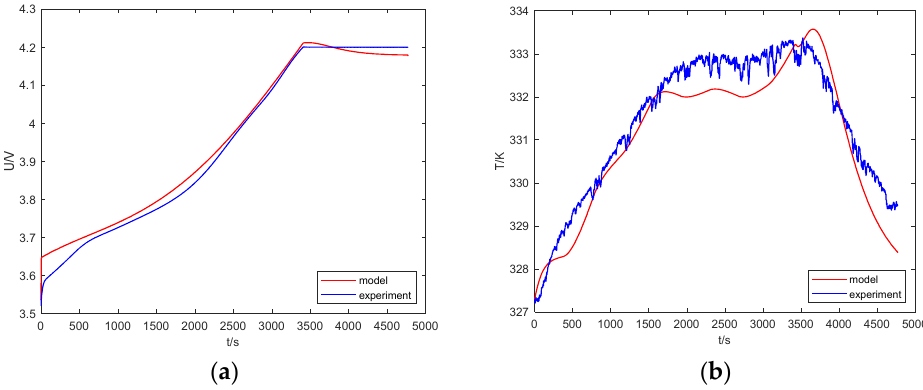
Figure 5. Comparison of terminal voltage and temperature between model simulation and experiment: ( a ) terminal voltage curve; ( b ) temperature curve.